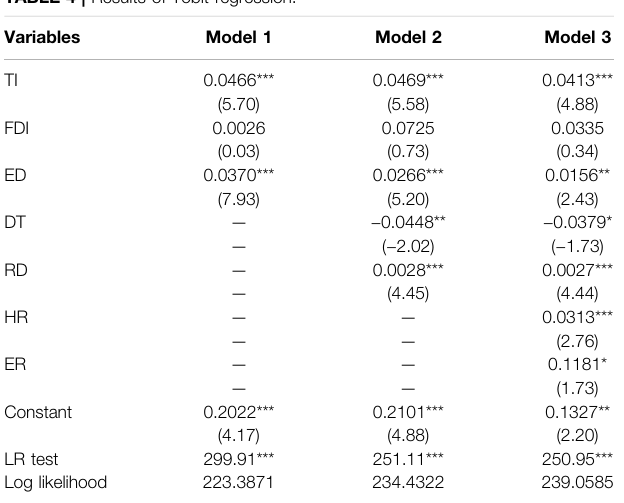
TABLE 4 | Results of Tobit regression. TABLE 5 | Results of the robustness